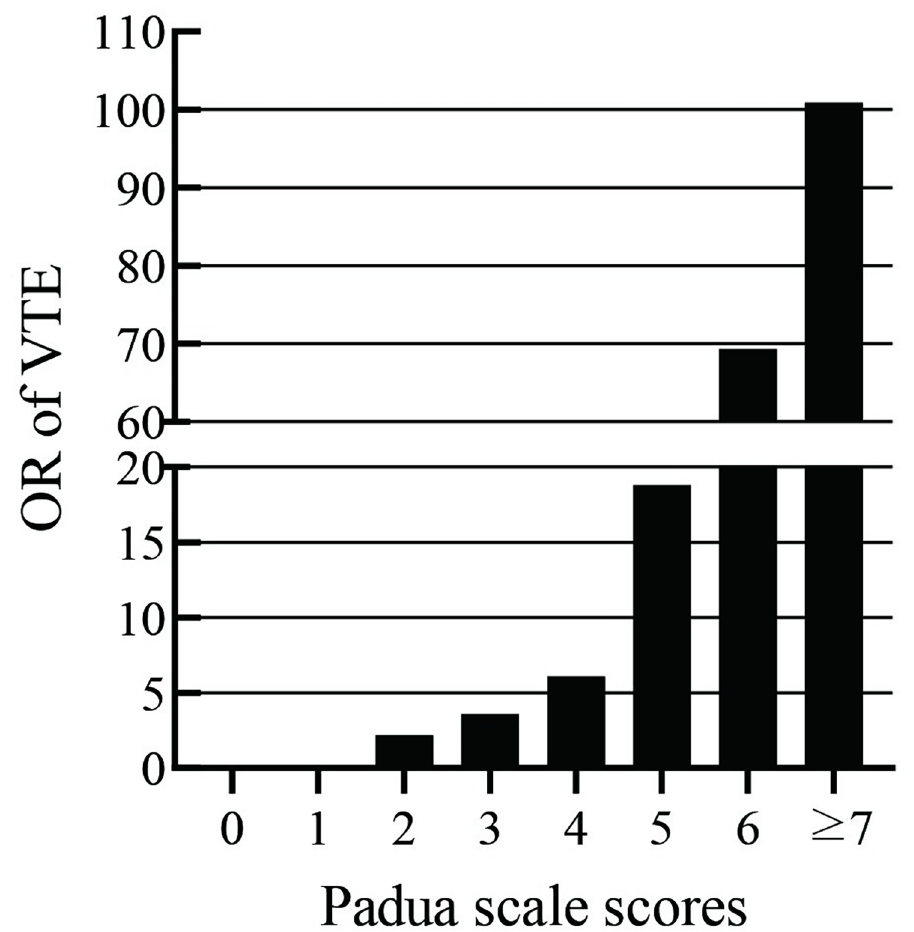
Fig 1. Padua scale scores and risk of VTE. VTE, venous thromboembolism, OR, odds ratio.